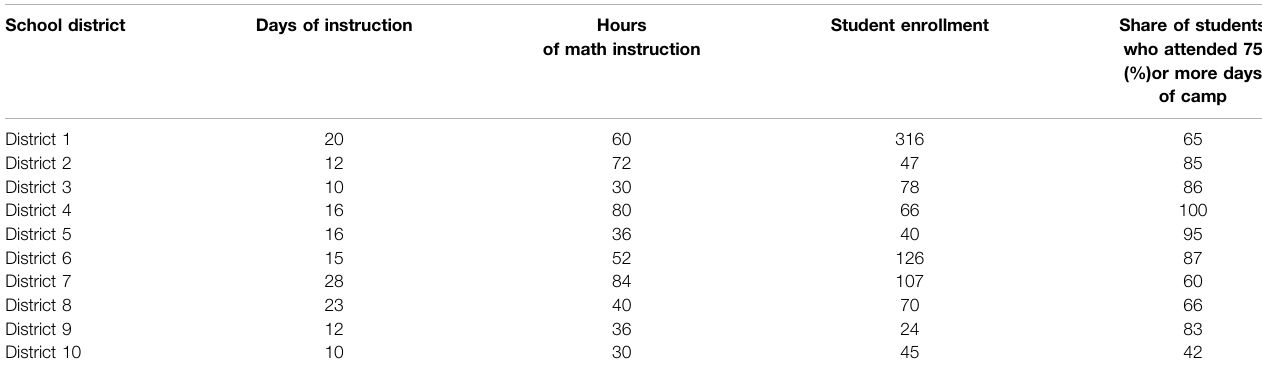
TABLE 2 | Camp implementation characteristics, by